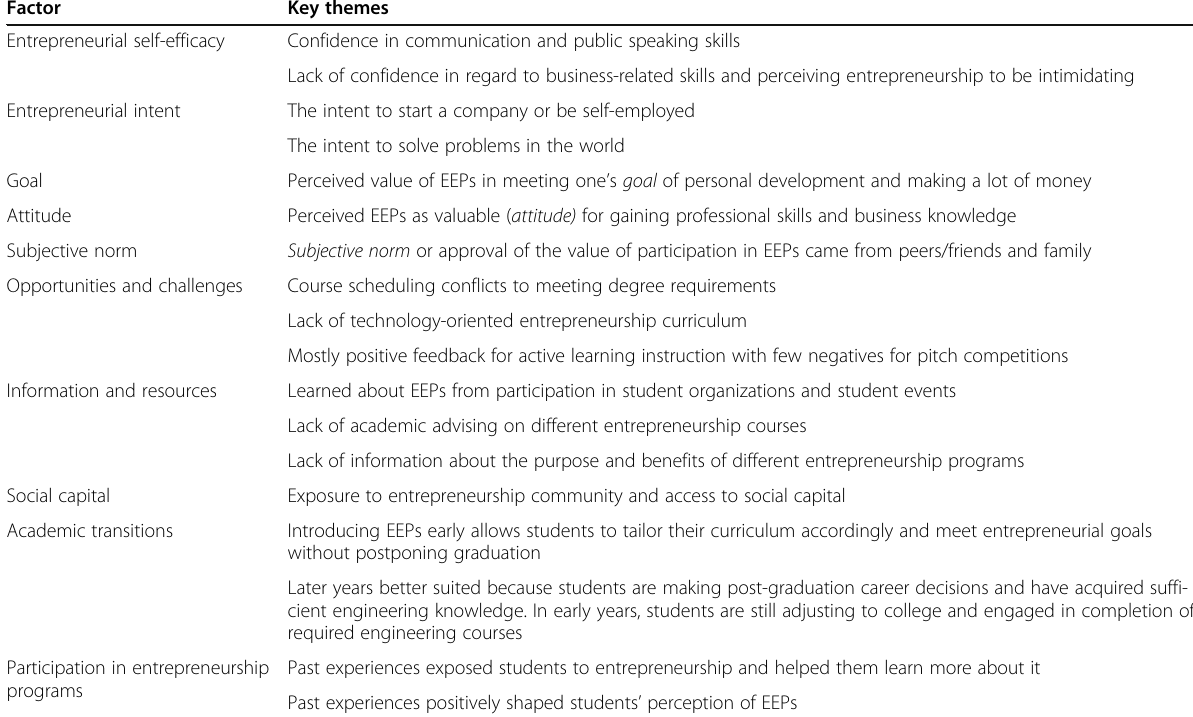
Table 3 Summary of themes